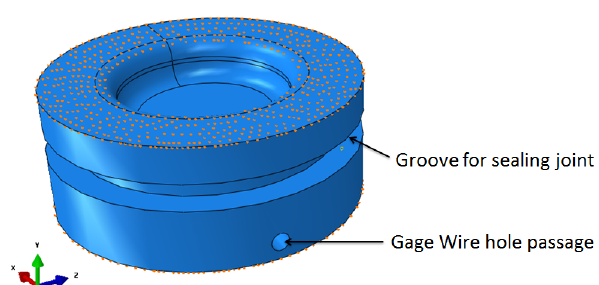
Figure 6. Sensor modeling with Abaqus FEA: applied load with boundary